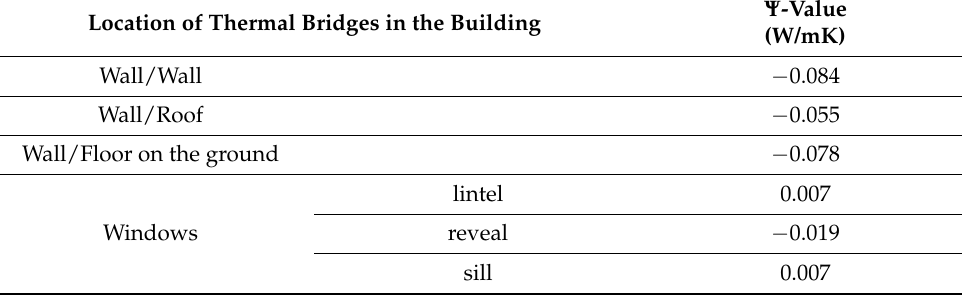
Table 3. A list of linear heat loss coefficients ( Ψ -value) of the thermal bridges in the building in question [135].